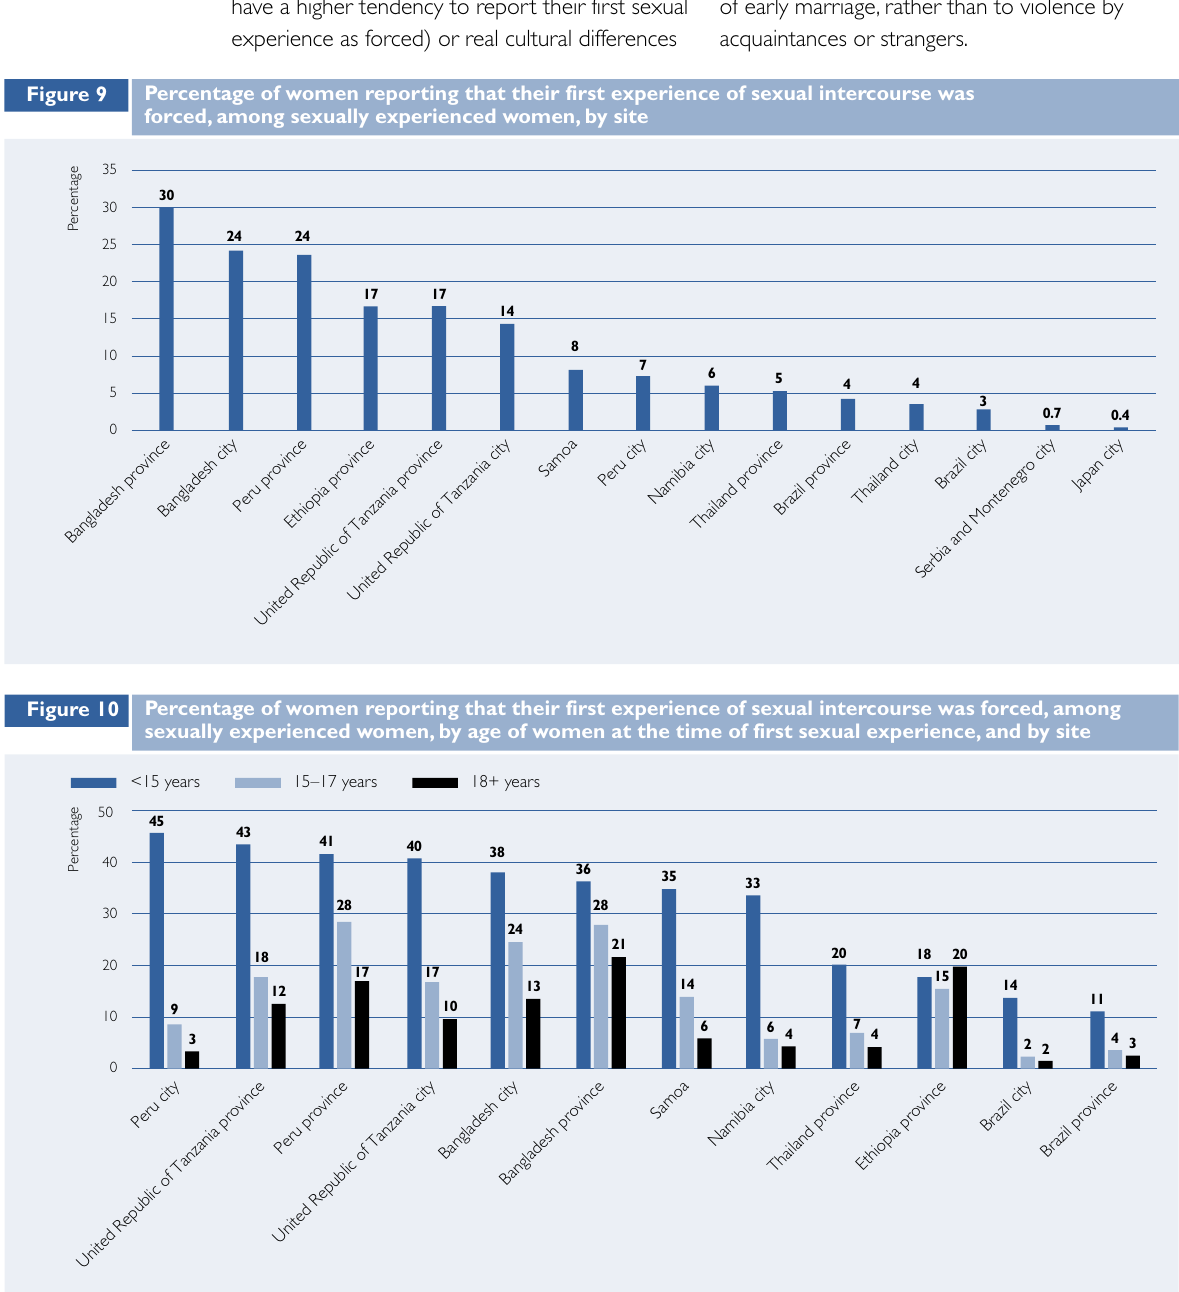
Note: Japan city, Serbia and Montenegro city, and Thailand city are not represented because of the low percentages reporting first sex before the age of 15